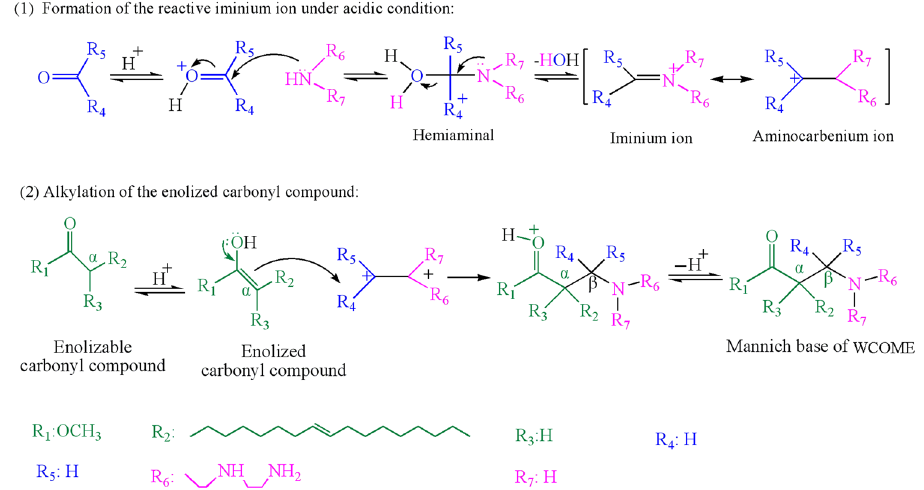
Figure 4. Synthesis mechanism of mannich base of